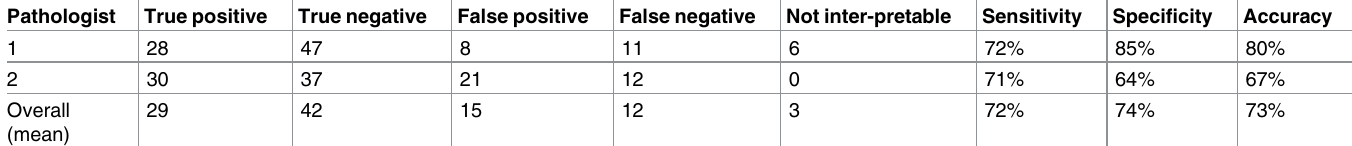
Table 3. Test characteristics of FF-OCT on pancreatic tissue. True positivesare FF-OCT imageswhichwere correctly identified as malignant. True nega- tives are FF-OCT images which were correctly identifiedas benign. False positivesare FF-OCT images which were incorrectlyidentifiedas malignant. False negativesare FF-OCT images which were incorrectly identifiedas benign.Pathologist1 is the experienced pathologist, pathologist2 is the pathologist in training.